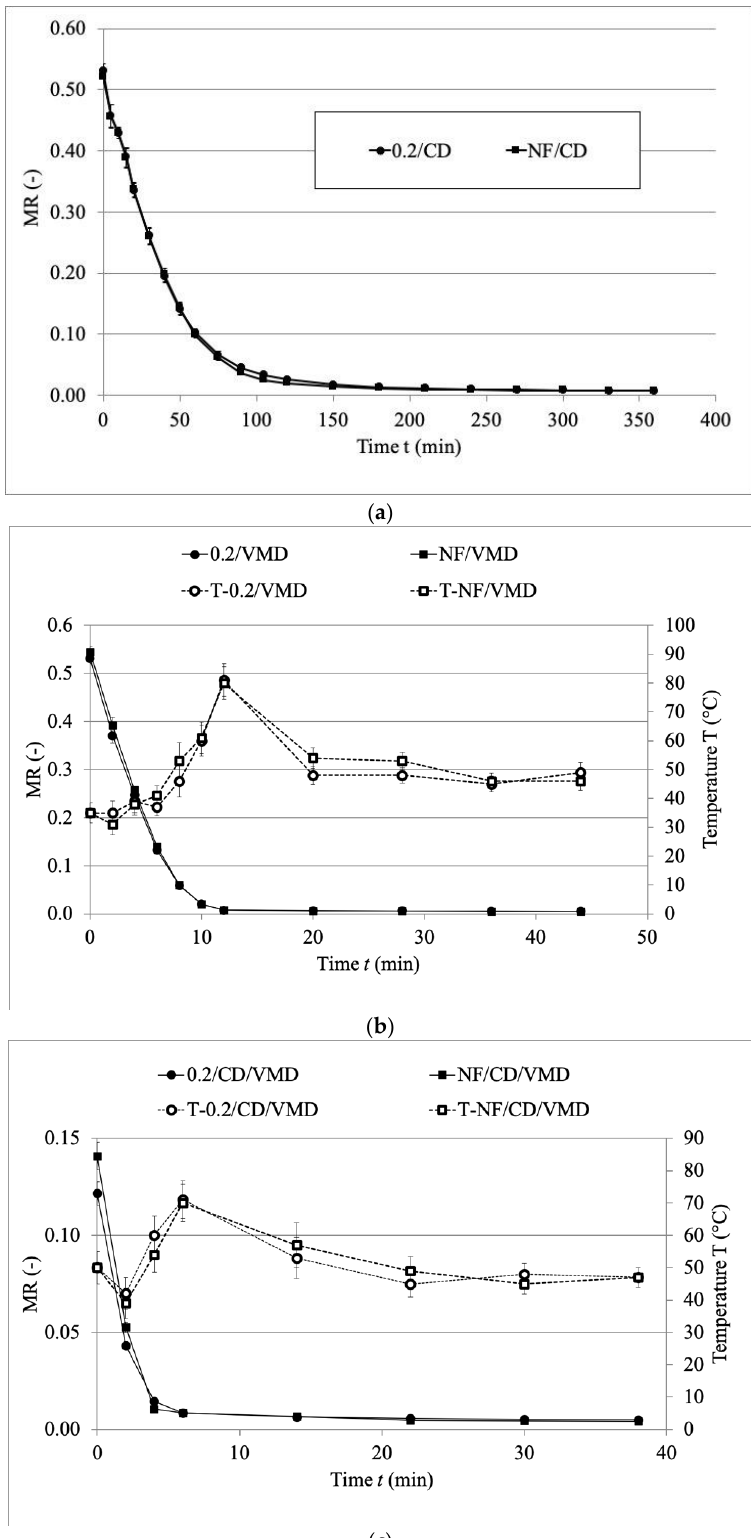
Figure 1. Drying kinetics of the samples dehydrated in filtrated and non-filtrated solutions and drying using ( a ) convective drying, ( b ) vacuum-microwave drying, ( c ) combined drying: convective pre-drying and vacuum-microwave finishing drying. T—series starting with this letter refer to temperature profile of the material during